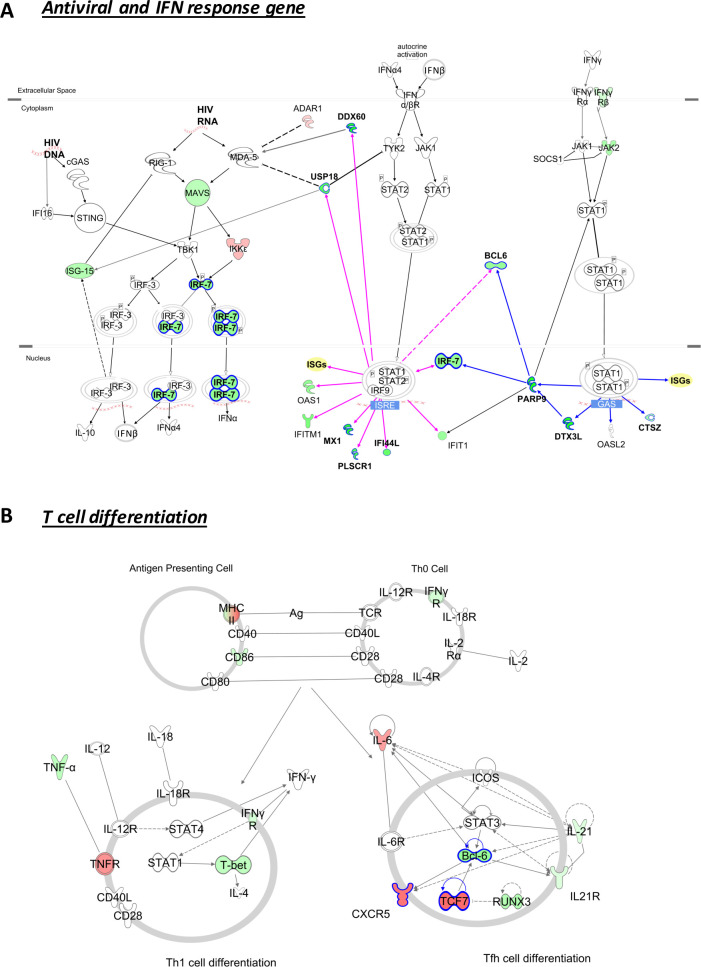
HIV-Low individuals show higher methylation levels in interferon stimulated genes and lower methylation levels in genes related to T follicular helper (Tfh).All differentially methylated CpG positions in the dataset (p<0.05) are shown in the context of two different pathways. A) Pathway representing genes associated with antiviral and interferon response focused on Role of RIG-I like Receptors in Antiviral Innate Immunity, Antiviral activation of IRF by cytosolic pattern recognition receptors and Interferon Signaling canonical pathways from IPA. B) Scheme showing T Helper Cell Differentiation canonical pathway from IPA combined with reported genes associated with Tfh phenotype. Coloring is based on methylation fold-change HIV-High/HIV-Low. Red refers to lower methylation in HIV-Low, and green higher methylation in HIV-Low. Also, pink and blue in (A) indicate the ISGs that are induced via type I or type II interferon, respectively. Molecules selected in the multivariate are highlighted with a blue border. Solid lines indicate direct interactions and dashed ones, indirect interactions.